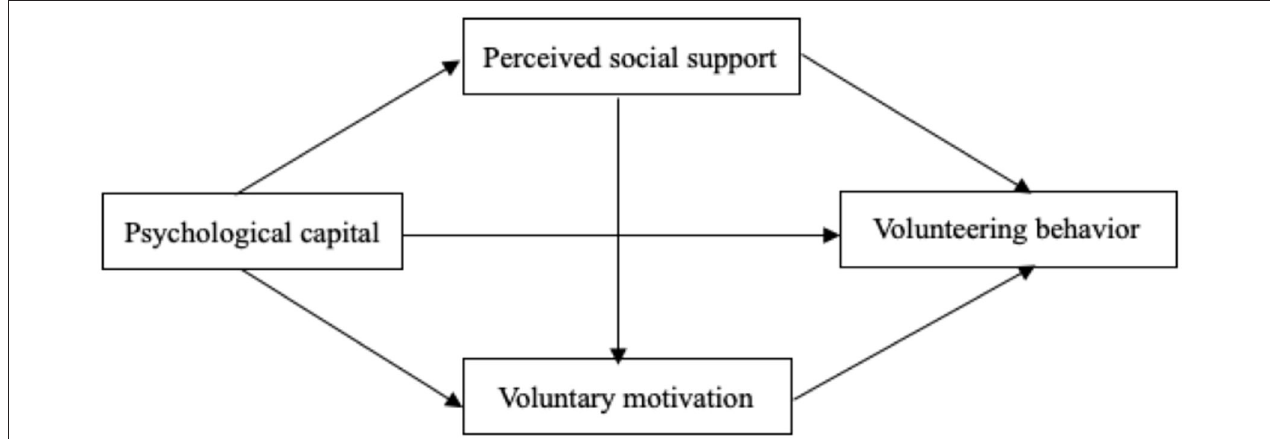
FIGURE 1 | Model of the chained mediating effect of perceived social support and voluntary